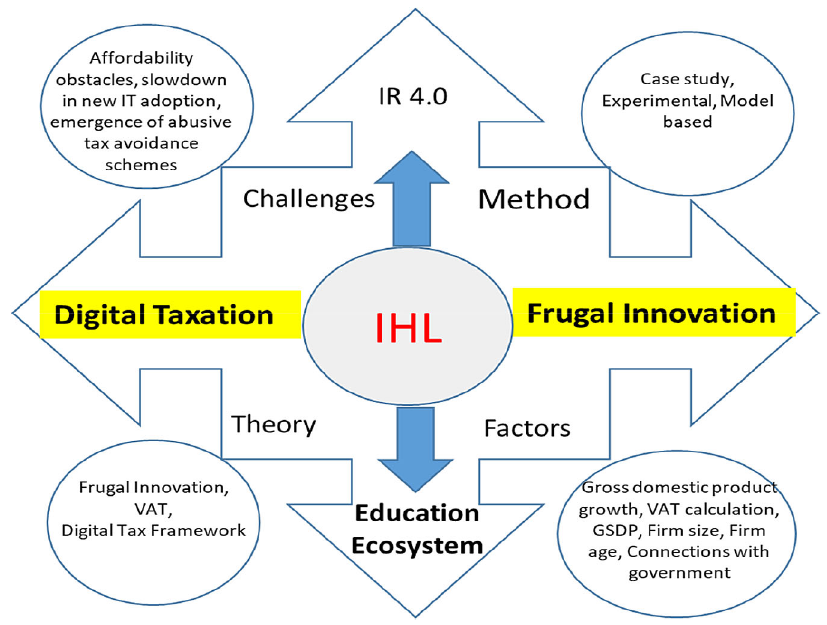
Figure 4. Proposed conceptual